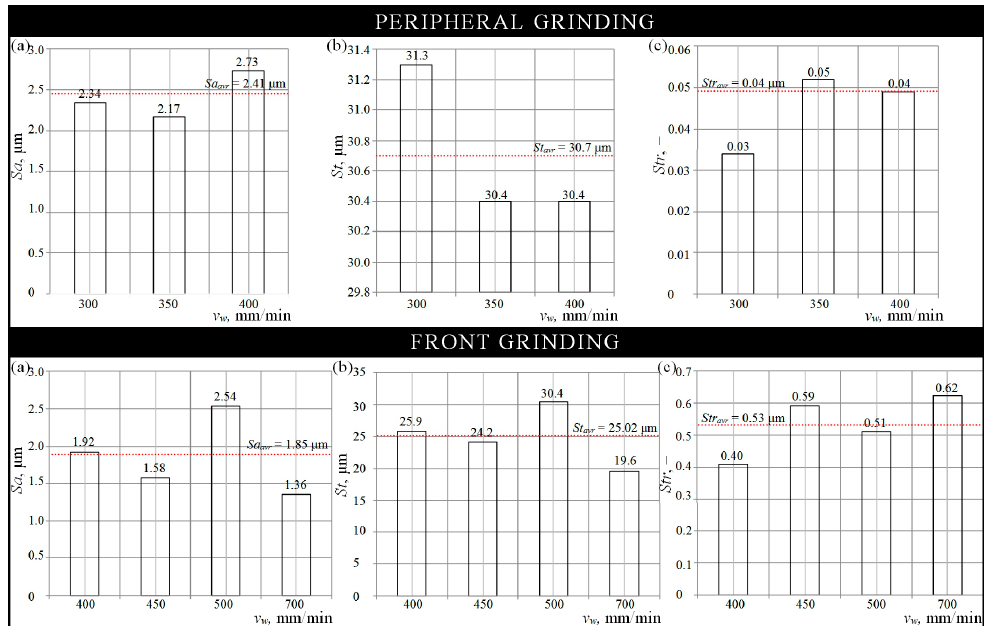
Figure 10. Collection of results in the form of bar graphs, representing values of essential surface texture parameters calculated in TalyMap Silver ver. 4.1.2 software, for the cutting edges of industrial cutting blades regenerated by the use of a 5-axis CNC grinding machine in a peripheral grinding process (top): ( a ) Sa ; ( b ) St ; ( c ) Str, and front grinding process (bottom): ( a ) Sa ; ( b ) St ; ( c ) Str.